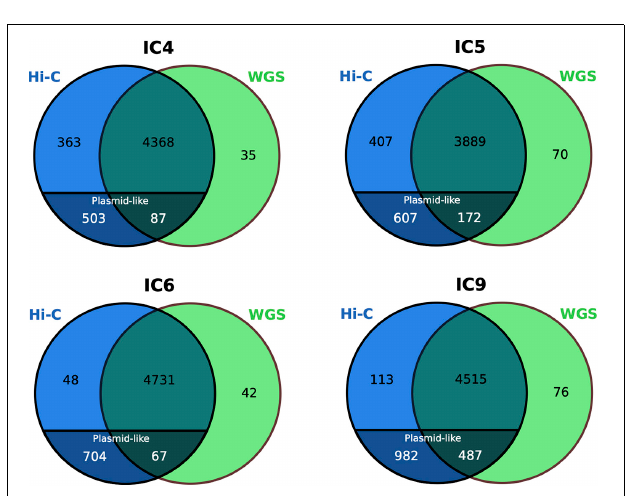
FIGURE 6 | Comparison of the K. pneumoniae gene set between the WGS and Hi-C MAGs. The numbers for the plasmid-like contigs of Hi-C MAGs are particularly shown. The Venn diagrams are based on COG